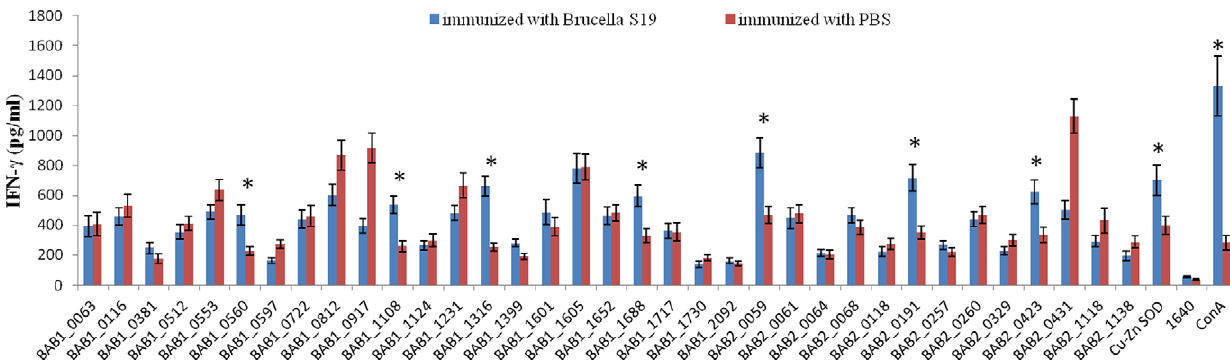
Figure 2. IFN- c secretion by splenocytes stimulated with the recombinant B.abortus proteins. Spleen cells from mice immunized with S19 or PBS were stimulated in vitro with recombinant proteins, ConA (positive control), or complete medium (negative control). Supernatants were collected and IFN- c was determined by using an ELISA Quantikine Mouse kit (R&D Systems). All assays were performed in triplicate and the concentrations for IFN- c in the culture supernatants were calculated by using the quantification formula. Significant differences between S19- immunized mice and PBS-immunized mice are indicated as follows: *, P , 0.001.